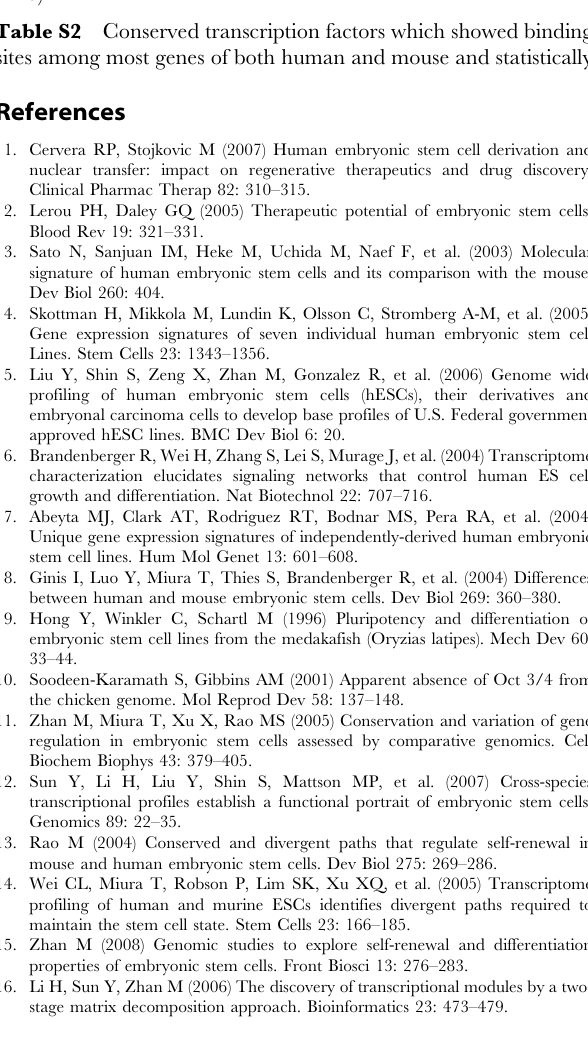
number of pathways where the conserved transcription factor were Table S3 Probabilities of network transition between ESC and EB states in JAK/STAT and WNT pathways under single-, double-, and triple-gene interventions. Transcriptional interven- tion is presented as: transcriptional pattern at the initial state (e.g. ESC state) = . transcription pattern after intervention = . tran- scription pattern at the end state (e.g. EB state). In each state, the transcription pattern of each gene are presented by ternary values (i.e. 1, 2 1, 0, representing up-regulation, down-regulation, and no change). Table S4 Genes and transcription factors on the hESC, mESC, and hESC-mESC conserved co-expression networks, along with their expression patterns in ESCs and network connectivity (listed from the highest to lowest). XLS) Author Contributions Conceived and designed the experiments: MZ. Analyzed the data: YS HL YL MZ. Wrote the paper: MZ. Designed overall research: MPM MR. Edited the manuscript: MPM